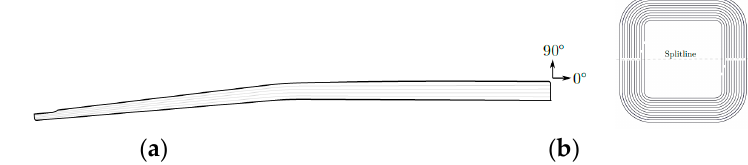
Figure 3. ( a ): Schematic of tiller design and ( b ) cross-sectional design of the tiller with internal split- line